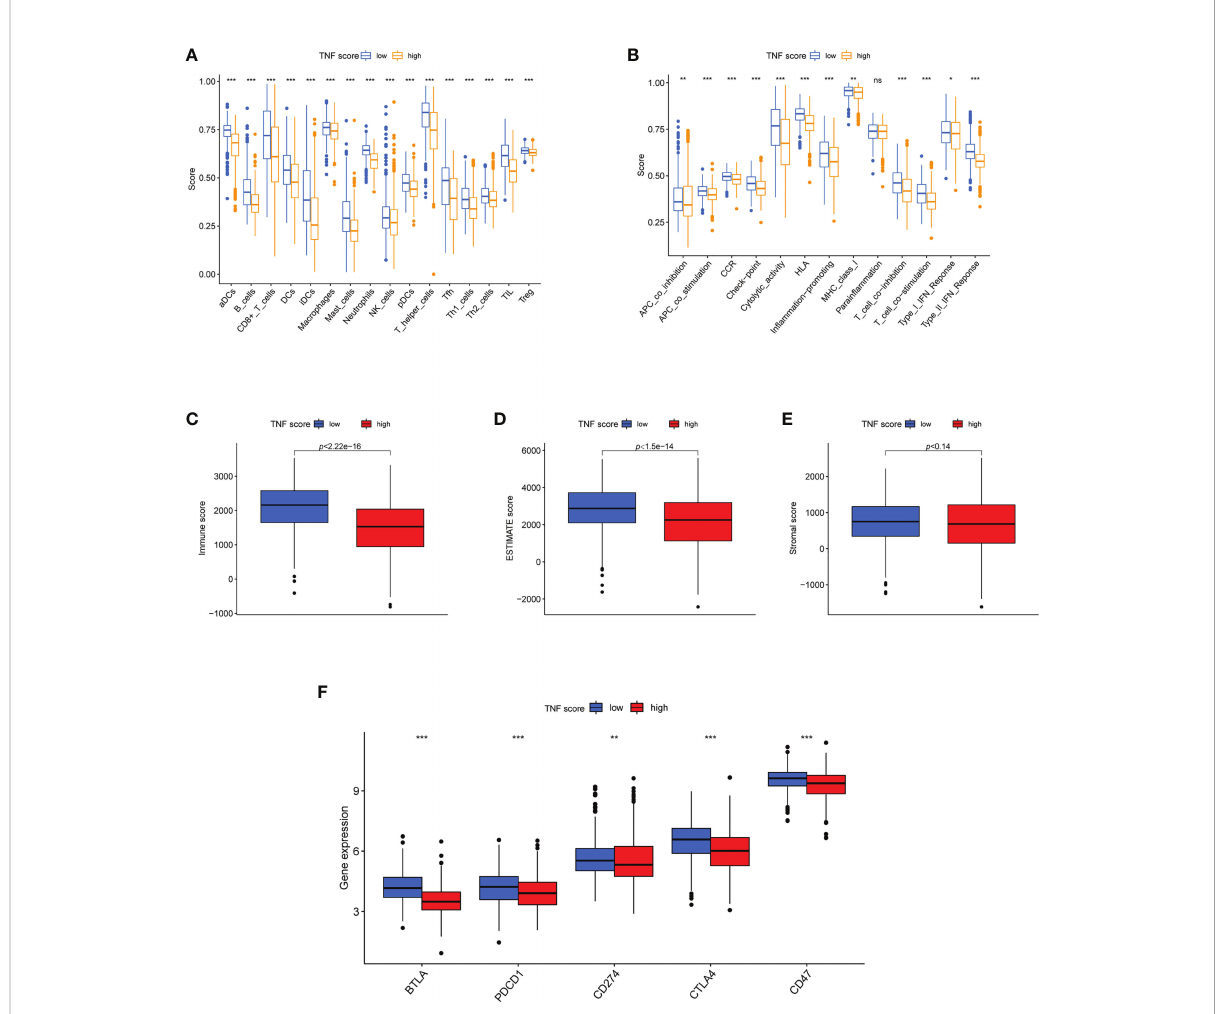
FIGURE 6 Features of TME in the high and low TNF score groups of LUAD. (A) The abundance of 16 in fi ltrating immune cell types in the high and low TNF score groups. (B) Correlation of the TNF scores and 13 immune functions. (C-F) Differences in the immune score, ESTIMATE score, stromal score and expression of fi ve common immune checkpoints between the different TNF score groups. *p < 0.05, **p < 0.01, ***p < 0.001, and ns p >